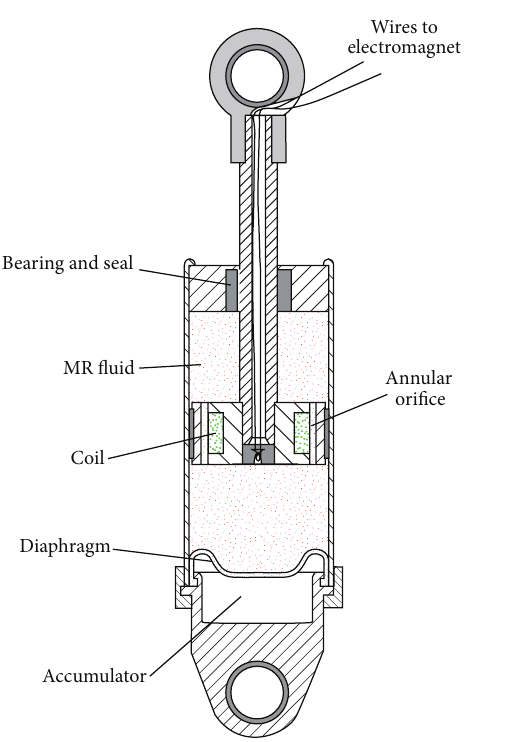
Figure 16: Typical scheme of a linear MR damper [16].